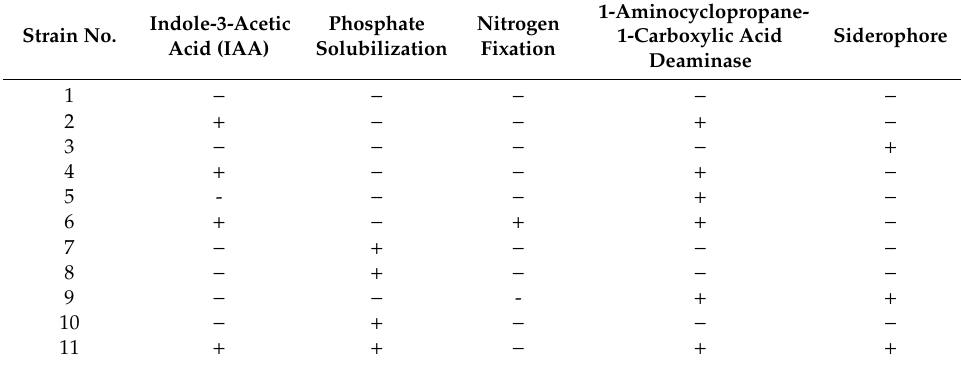
Table 1. Plant growth-promoting traits, where + indicates the possession of the following trait, and – indicates the lack of the trait.